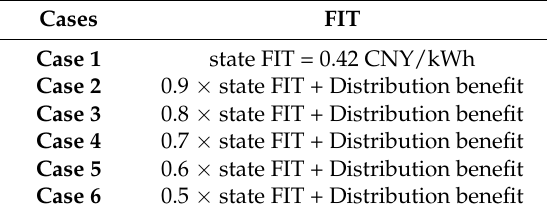
Table 10. Case introduction. The distribution benefit evaluation is shown in Figure